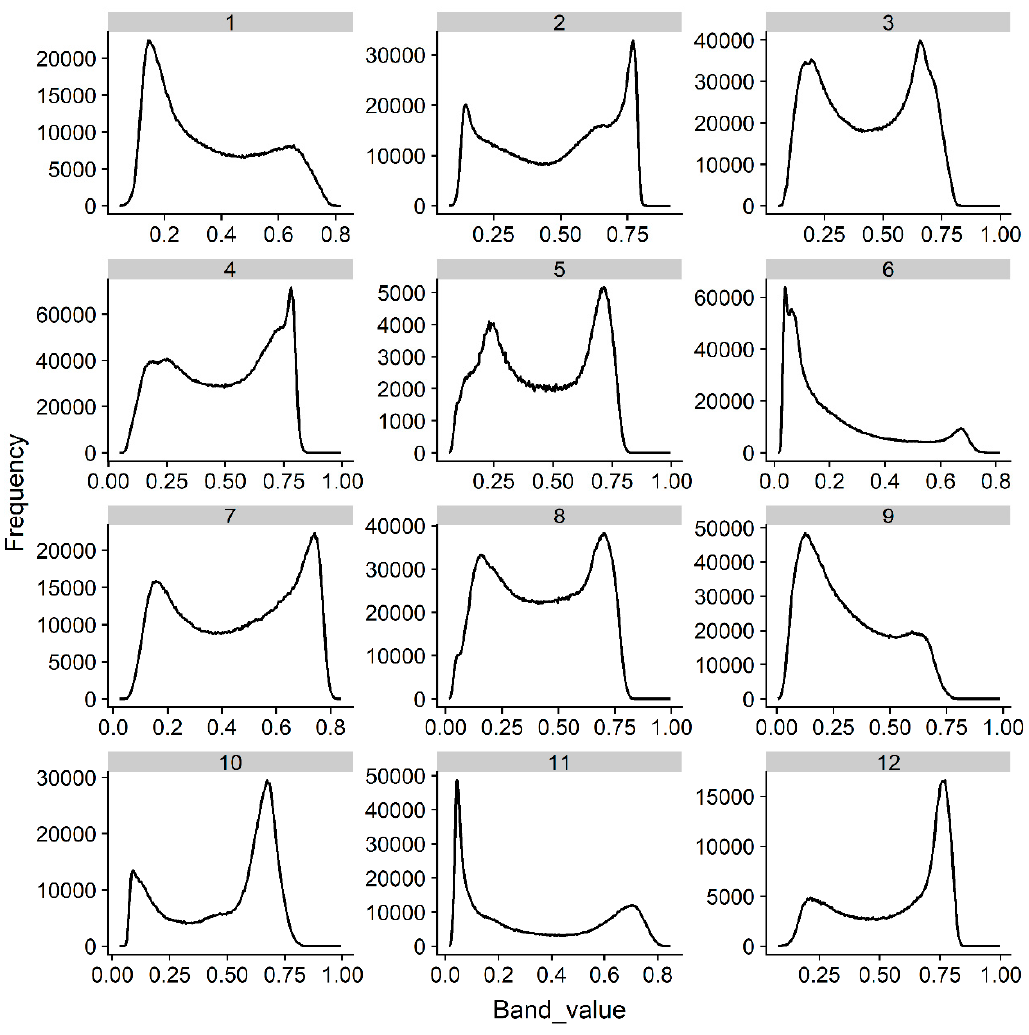
Figure 10. The histogram of NDVI_max data for selected cities.